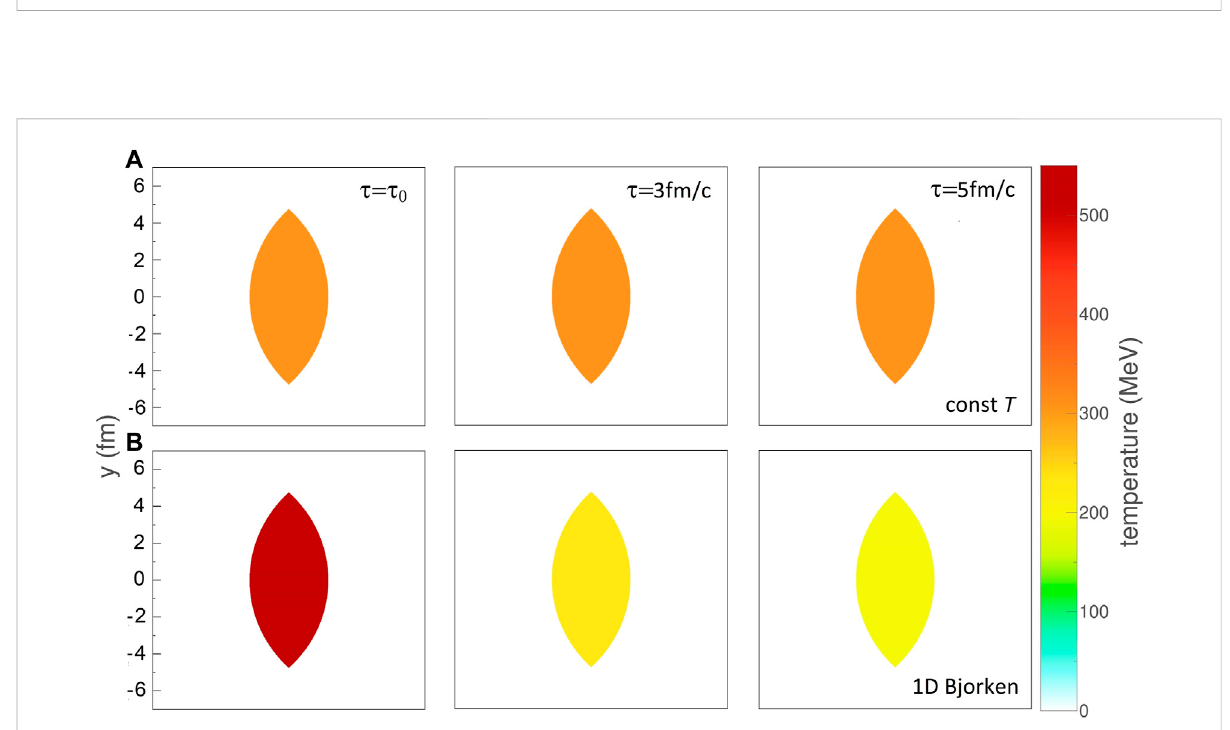
FIGURE 3 Temperaturedistribution(Pb+Pbcollision,30 – 40%centrality,mid-rapidity)forconstanttemperature[50] (A) and1DBjorkenevolution[51] (B) , attime(fromlefttoright) τ = τ 0 ,3,and fi vefm/ c ,representedbycolourmapping.Forconstanttemperatureapproximation, τ 0 =0 fm.For1DBjorken approximation, τ 0 = 0.6